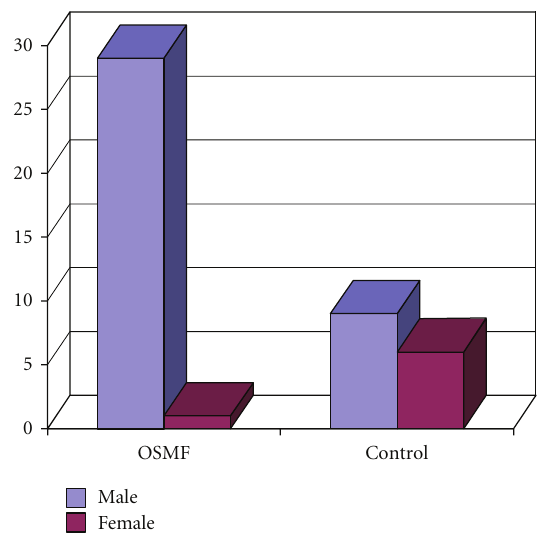
Figure 1: Gender distribution in study groups.